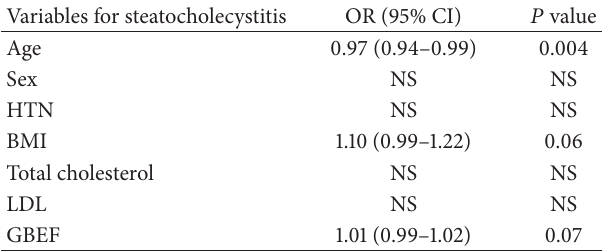
Table 6: Multivariable analysis for clinical risk factors of steatoc- holecystitis in patients with calculous cholecystitis. Variables for